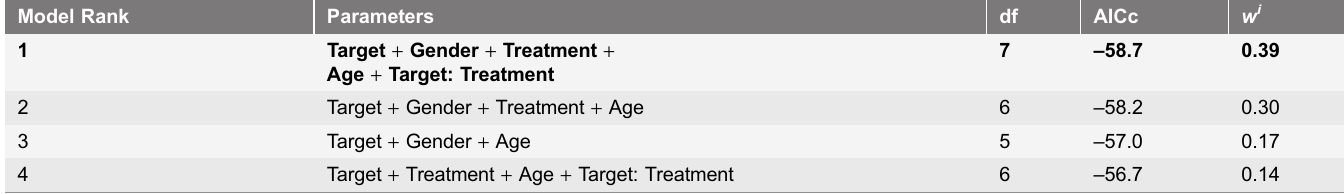
Table 4. GLM to investigate factors affecting mean donation made by Player 1.